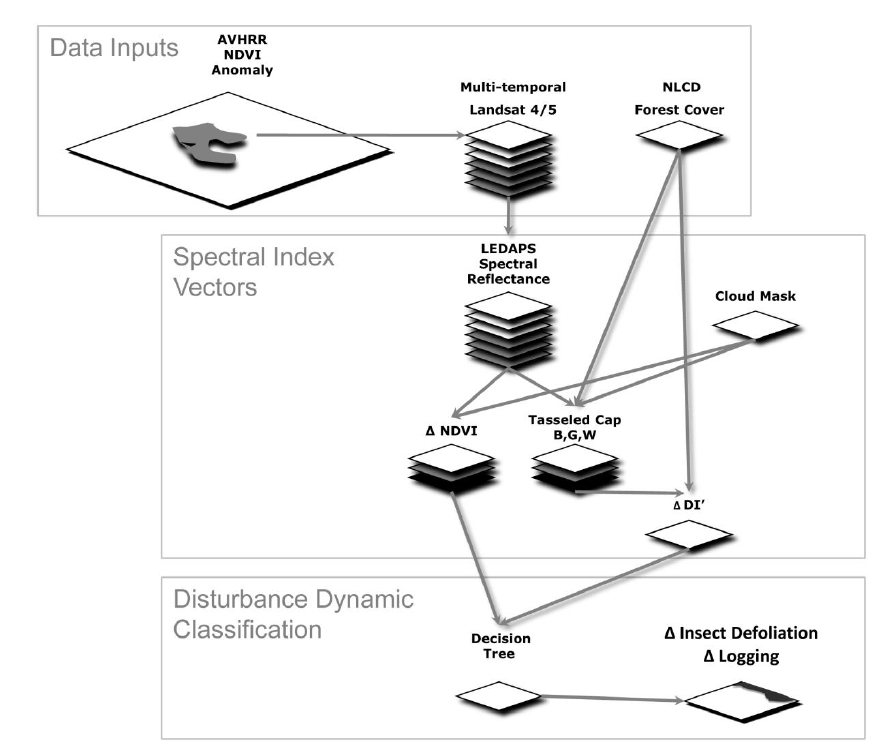
Figure 2. Illustration of annual Landsat classification used to understand disturbances on forest productivity trends. NLCD, National Land Cover Database; LEDAPS, Landsat Ecosystem Disturbance Adaptive Processing System; DI’, Disturbance